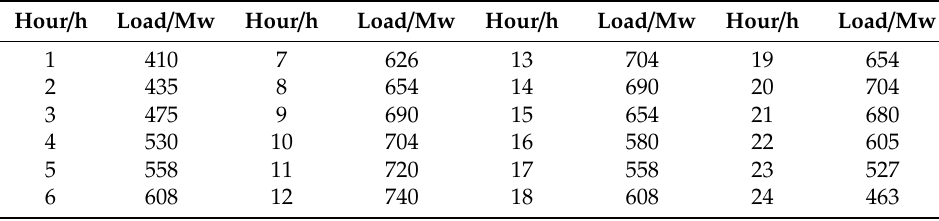
Table 1. Load data without plug-in electric vehicles